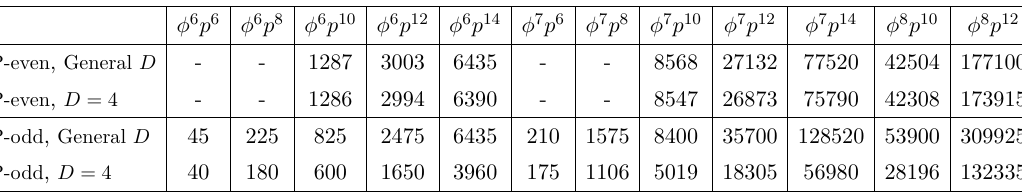
Table 1 . The number of independent local amplitudes, or kinematic invariants, in both general D and D = 4 . The difference is due to the constraints in eqs. (2.9) and (2.10). For parity-even operators eq. (2.9) is effective only at the order p n ≥ 2 D . The numbers are computed using the package ABC4EFT